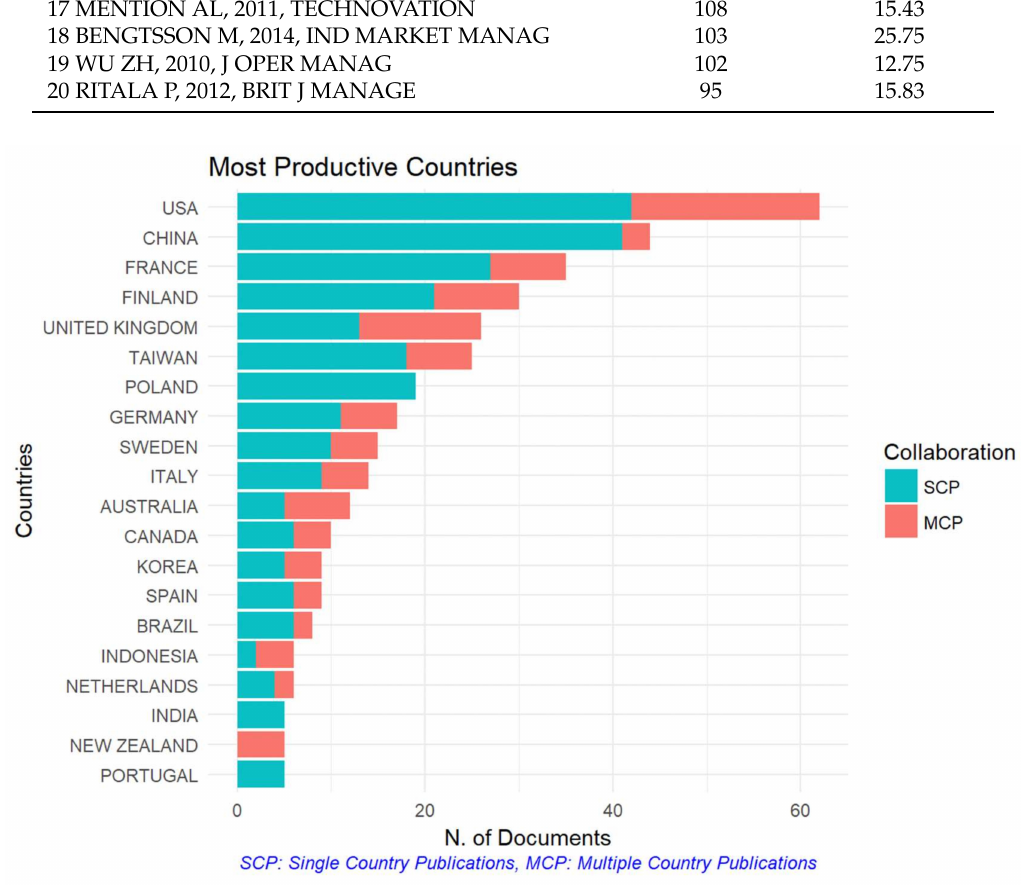
Figure 2. The most productive